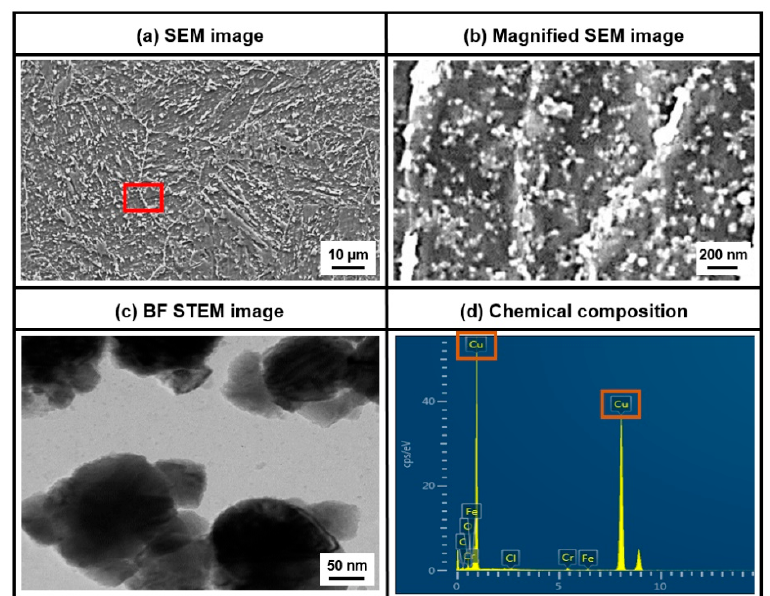
Figure 6. Microstructures of the LH P21 at the boundary of the heat-treated region (labeled as “B” in Figure 5a); ( a ) top-sectional SEM image, ( b ) magnified SEM image at the red box in ( a ), ( c ) bright field STEM image of precipitates, and ( d ) chemical composition of precipitates obtained from the EDX analysis.